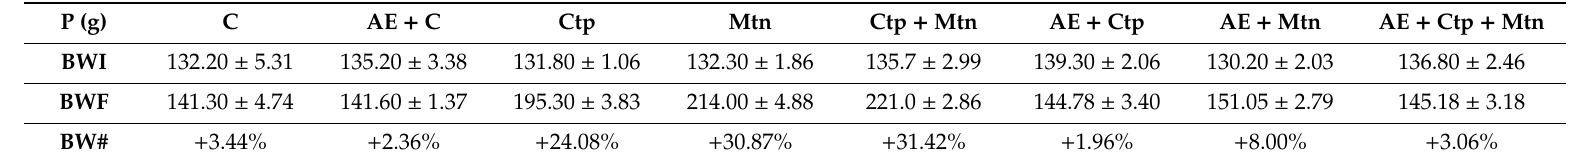
Table 1. Impact of cartap, malathion and A. vera extract on rat body weight, levels of MDA and